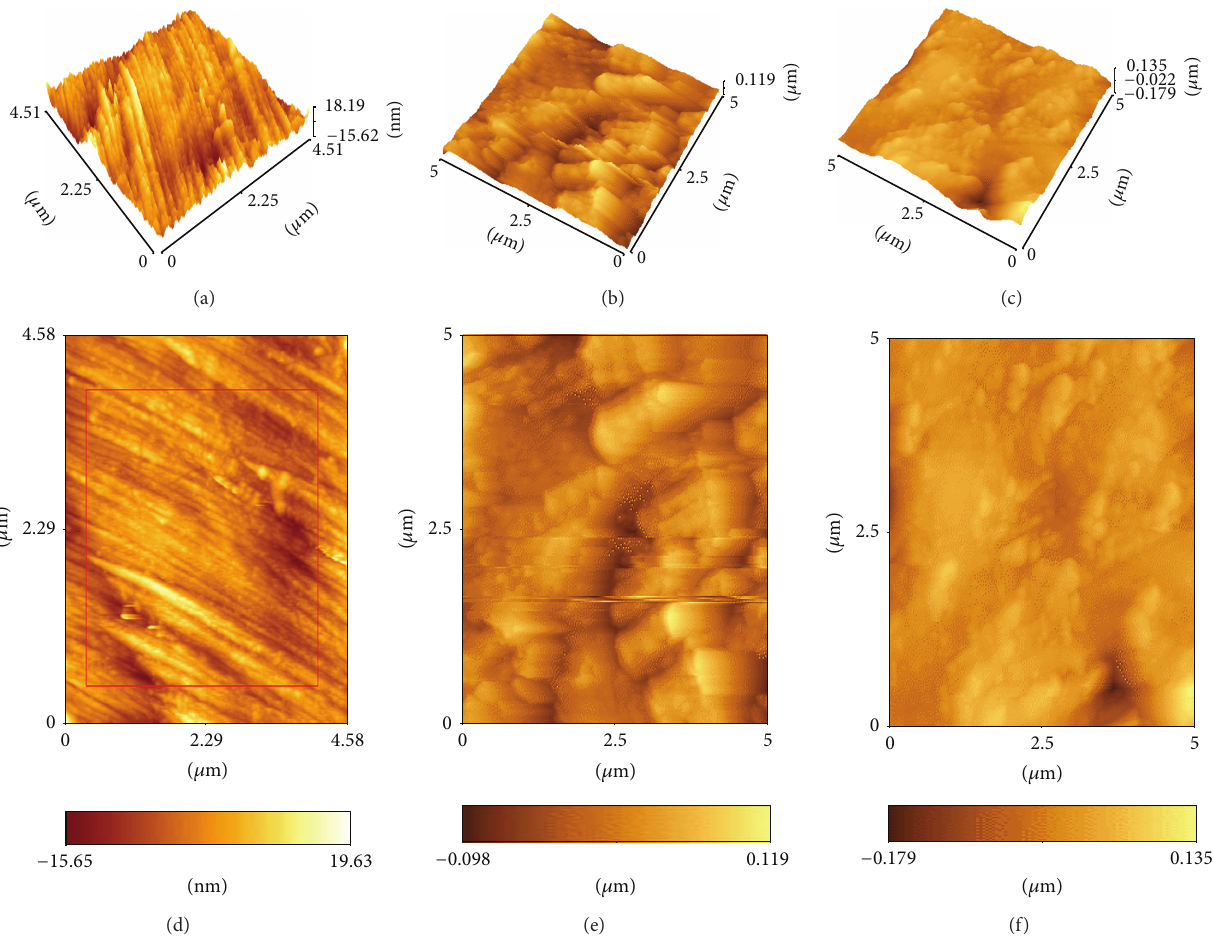
Figure5:Three-dimensionalAFMimagesofthesurfaceof(a)polishedcarbonsteel(control).(b)Carbonsteelimmersedinseawater(blank). (c) Carbon steel immersed in sea water containing L-Arg (250 ppm) + Zn 2+ (25 ppm). (d) Polished carbon steel (control). (e) Carbon steel immersed in sea water (blank). (f) Carbon steel immersed in sea water containing L-Arg (250ppm) + Zn 2+ (25ppm). Table 7: AFM data for carbon steel surface immersed in inhibited and uninhibited environments. RMS (Rq) roughness Average (Ra) Sample (nm)